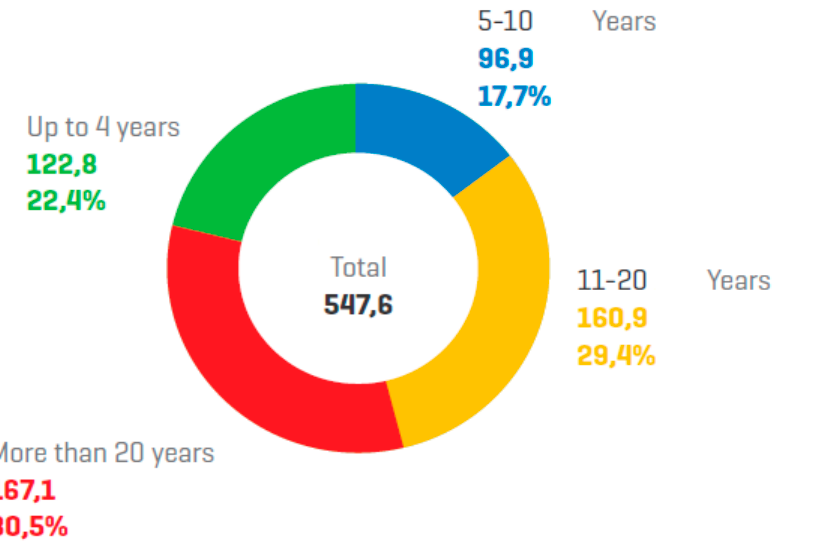
Figure 4. Age structure of heavy goods vehicles in Poland (over 3.5 PGW) updated in the last 6 years in CEP [14].